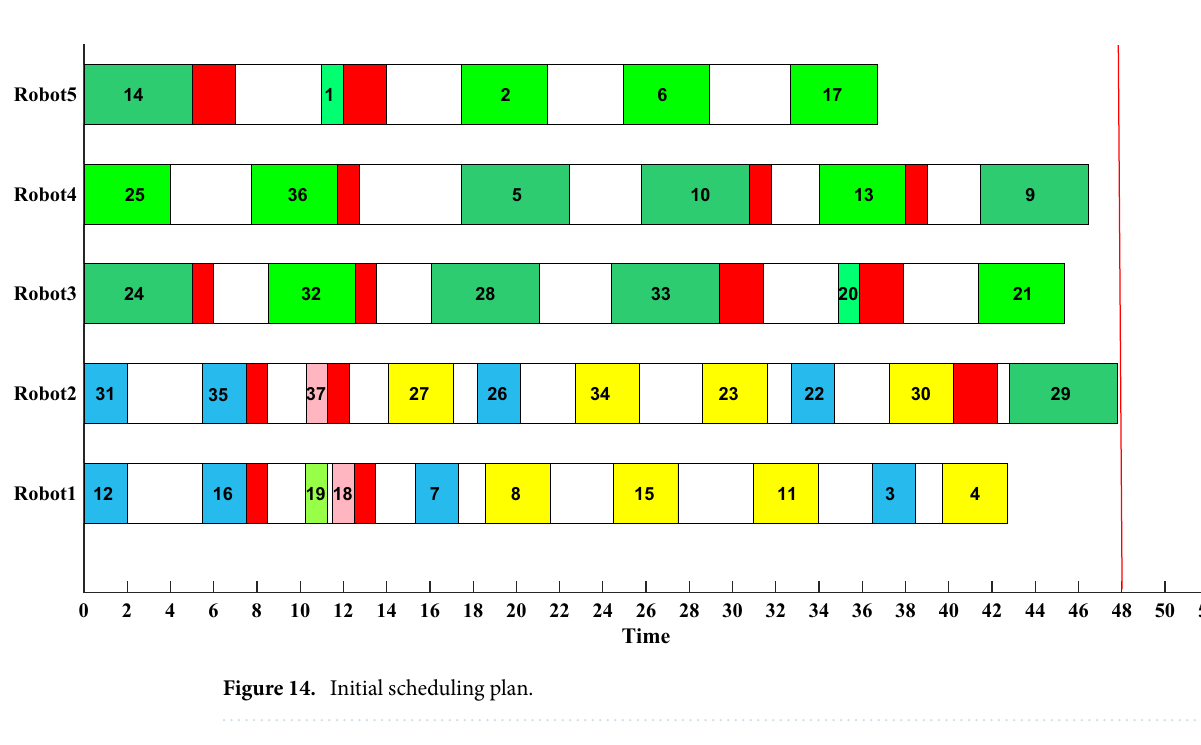
Figure 14. Initial scheduling plan.